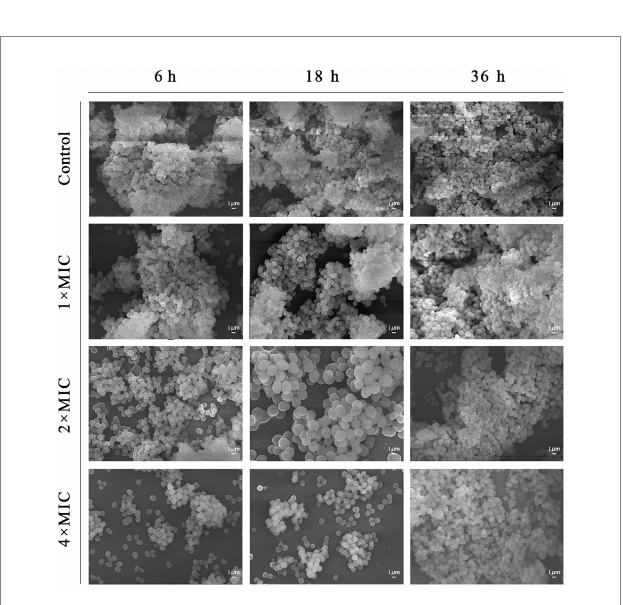
FIGURE 6 SEM images showing the effects of erythromycin on SEP-05. Magnification: